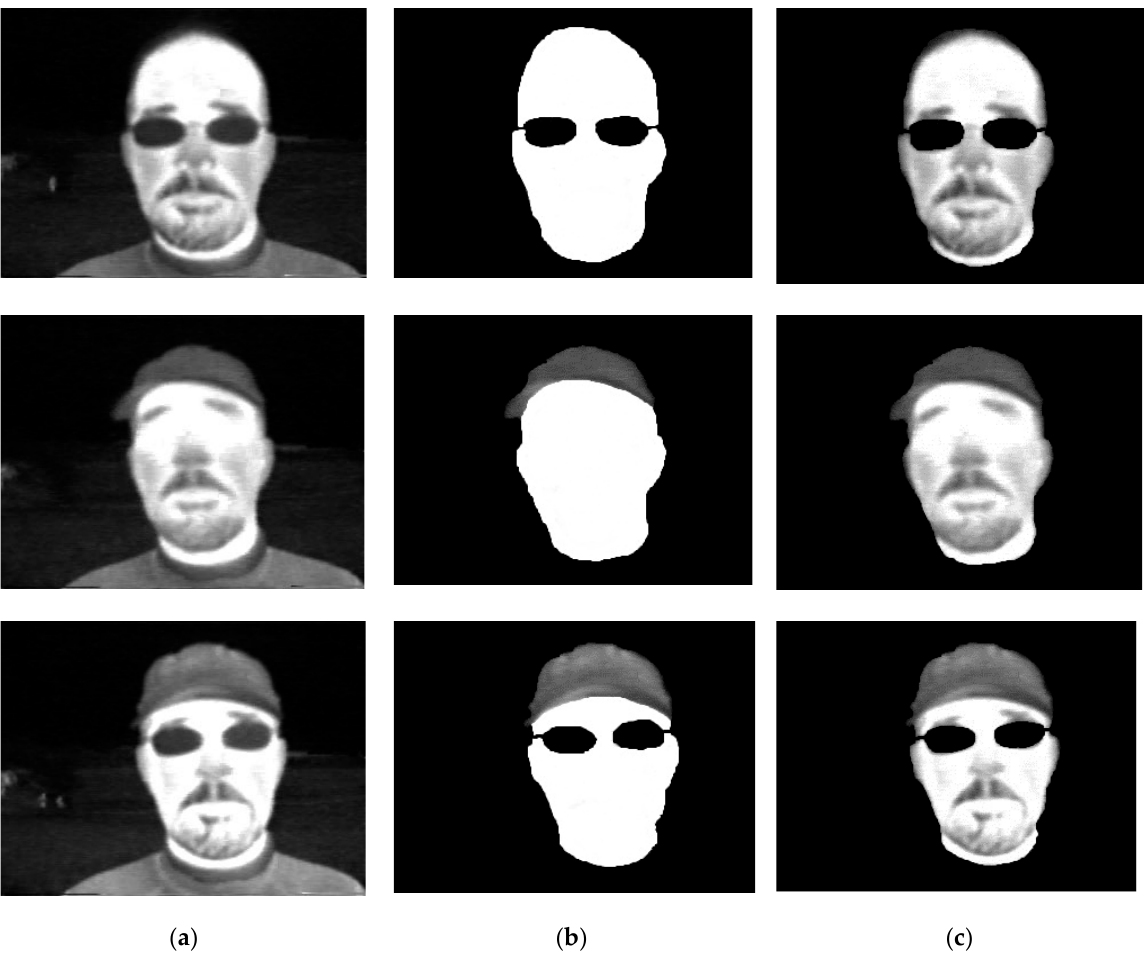
Figure 3. Extracting the faces. ( a ) Original Image. ( b ) Feature Extraction. ( c ) Face Extraction.